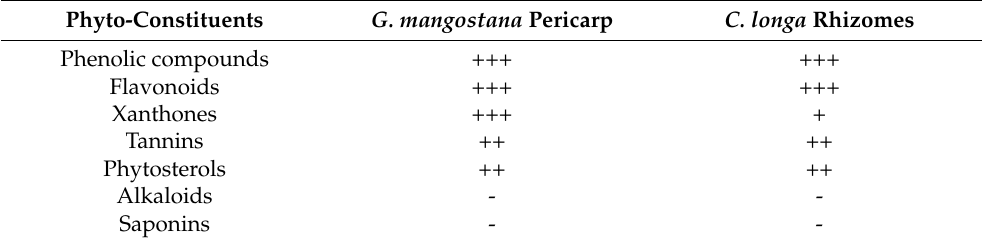
Table 1. Qualitative phytochemical analysis of the solvent fractions of the methanol extracts of G. mangostana pericarp and C. longa rhizomes. Phyto-Constituents G. mangostana Pericarp Phenolic compounds